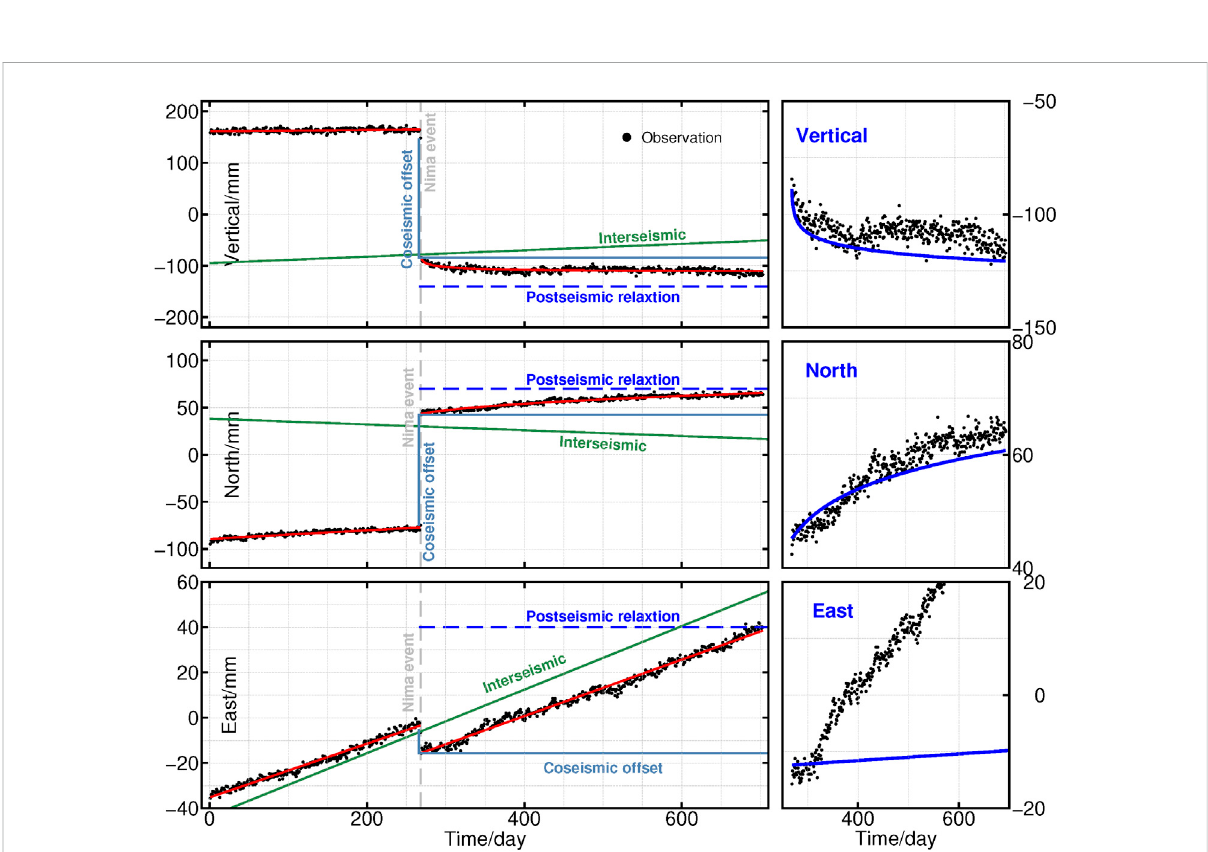
FIGURE 4 Positiontimeseriesofpostseismictransientmotioninthesecondyearatthenear- fi eldGNSSstationROMA(blackdots)andthemodeledcurve (blue lines) for various combinations of Tibetan mantle transient and steady-state viscosities. The left panel shows the complete time series at this station, with the grey vertical lines, dark blue lines, and blue dashed lines representing the time of the mainshock, the coseismic offset, and the postseismic relaxation. The red and green lines in the left panel and blue lines in the right panel indicate the total signal, 1-dimensional linear fi tting of the long-period interseismic tectonic estimate, and the modeled curve,